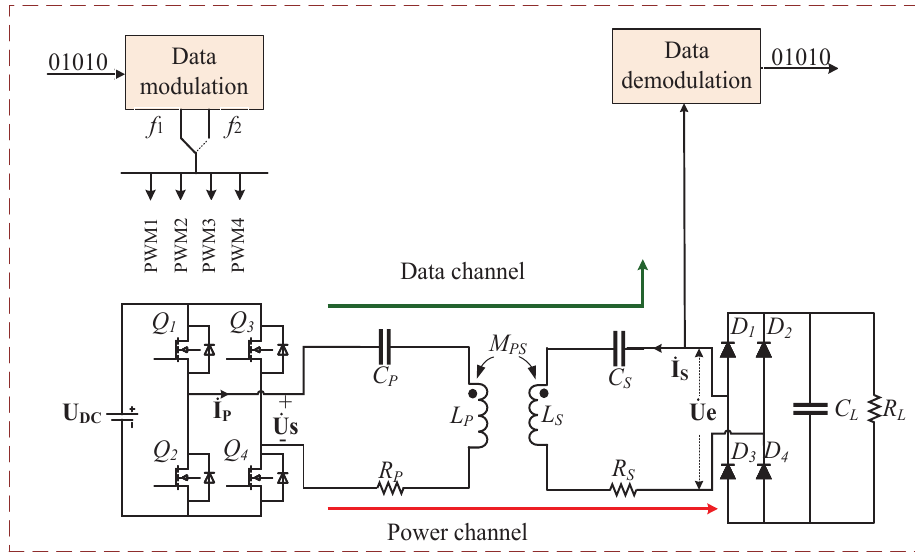
Figure 1. Schematic circuit of the proposed